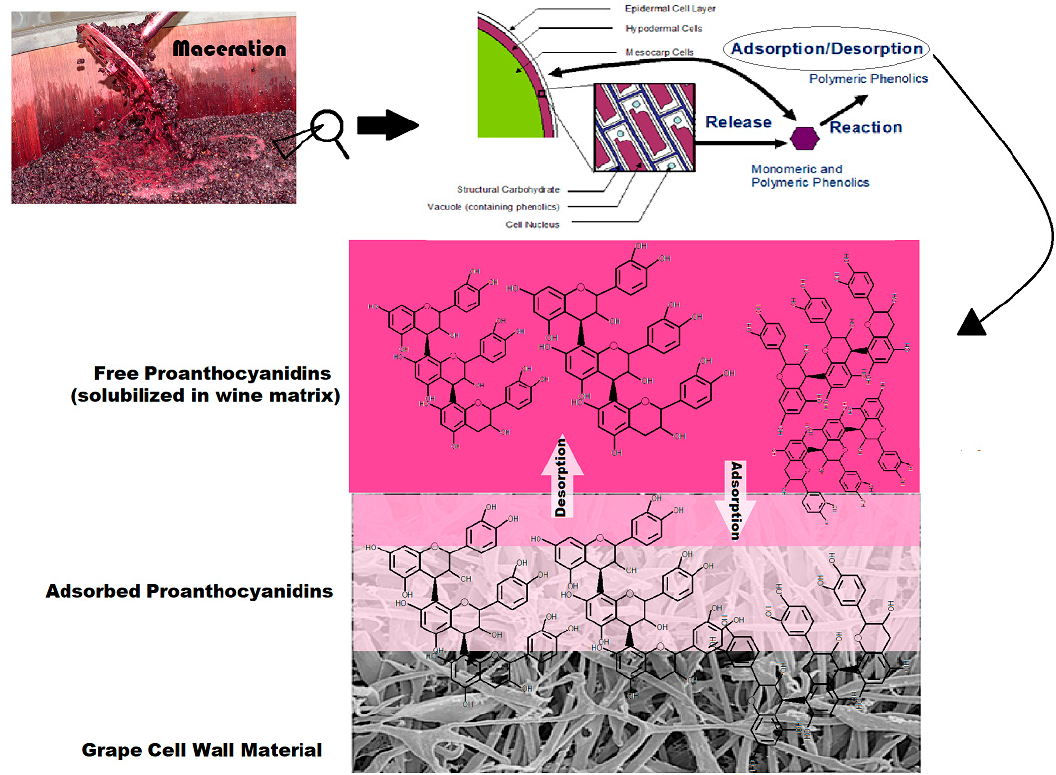
Figure 1. Representation of possible proanthocyanidins (PA) fate in red wine fermentation.